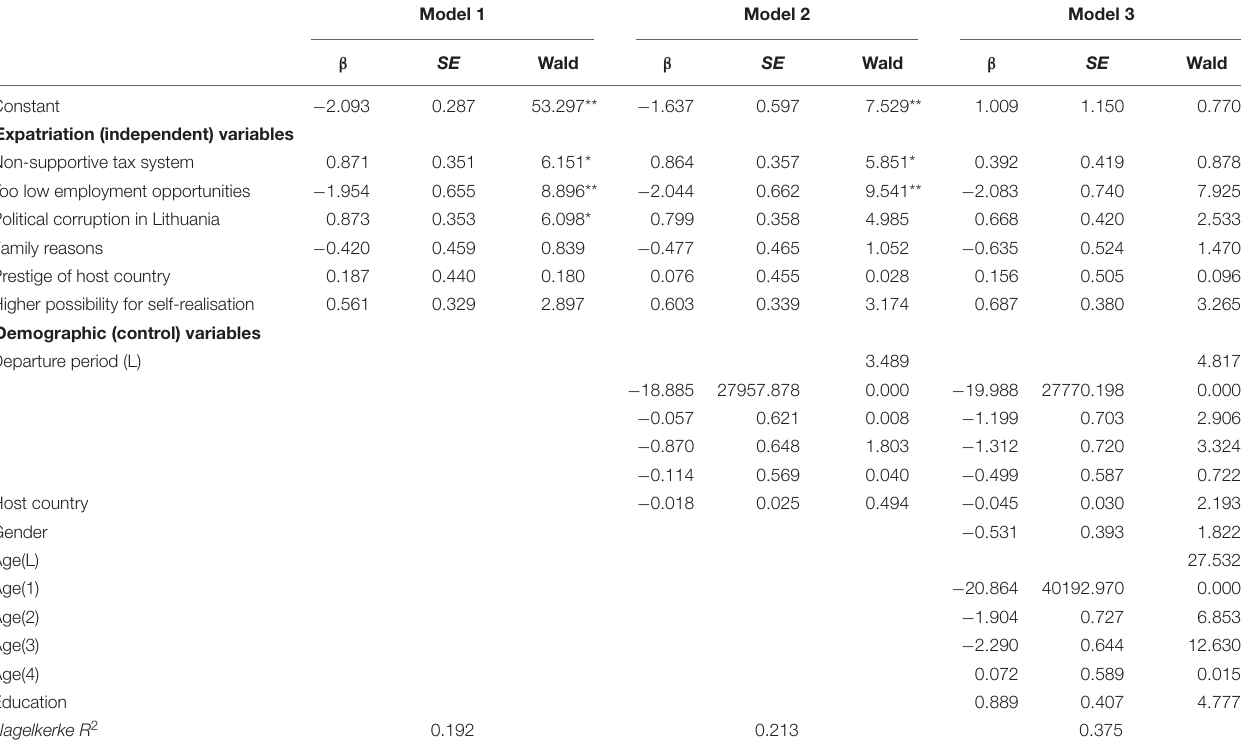
TABLE 5 | Results of logistic